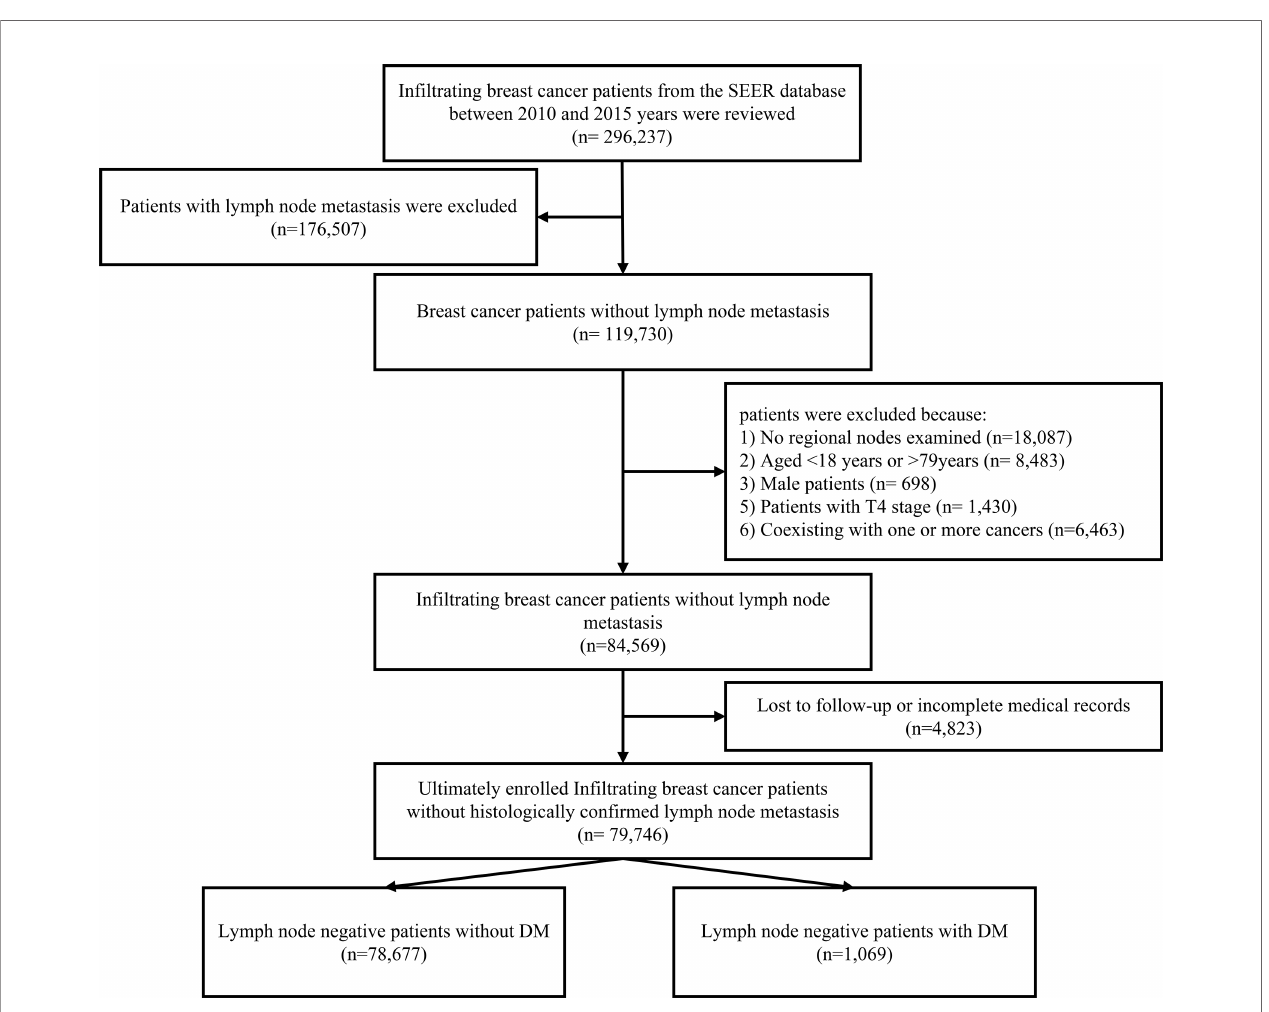
FIGURE 1 | The patients ’ selection processing. T4, invasion to the chest wall/skin and in fl ammatory carcinoma; DM, distant